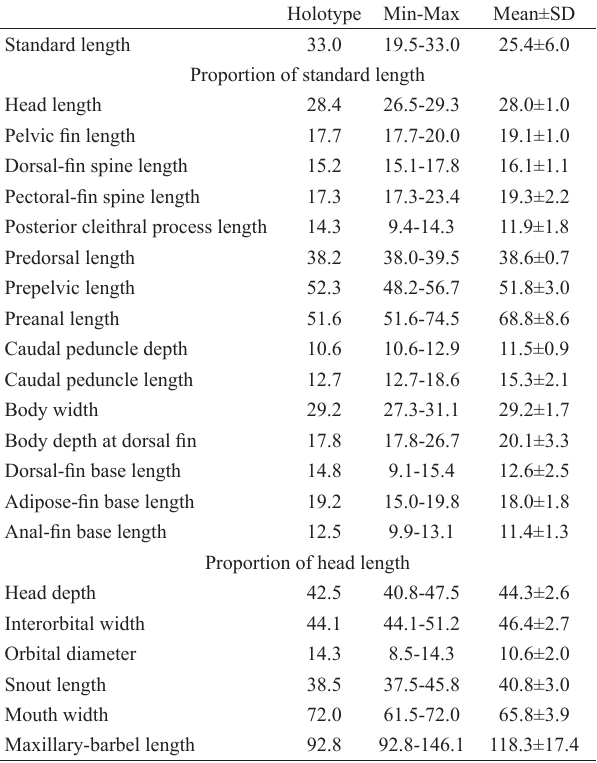
Fig. 2. Dorsal view of right pectoral-fin spine of holotype (ZUFMS 4148, 33.0 mm SL) of Microglanis leniceae , from the upper rio Paraguay basin, Mato Grosso State, Brazil. Scale bar = 1 mm. Table 1. Morphometrics of Microglanis leniceae from the upper rio Paraguay (n=6). Minimum and maximum (Min- Max) include the data of holotype. SD = Standard deviation.